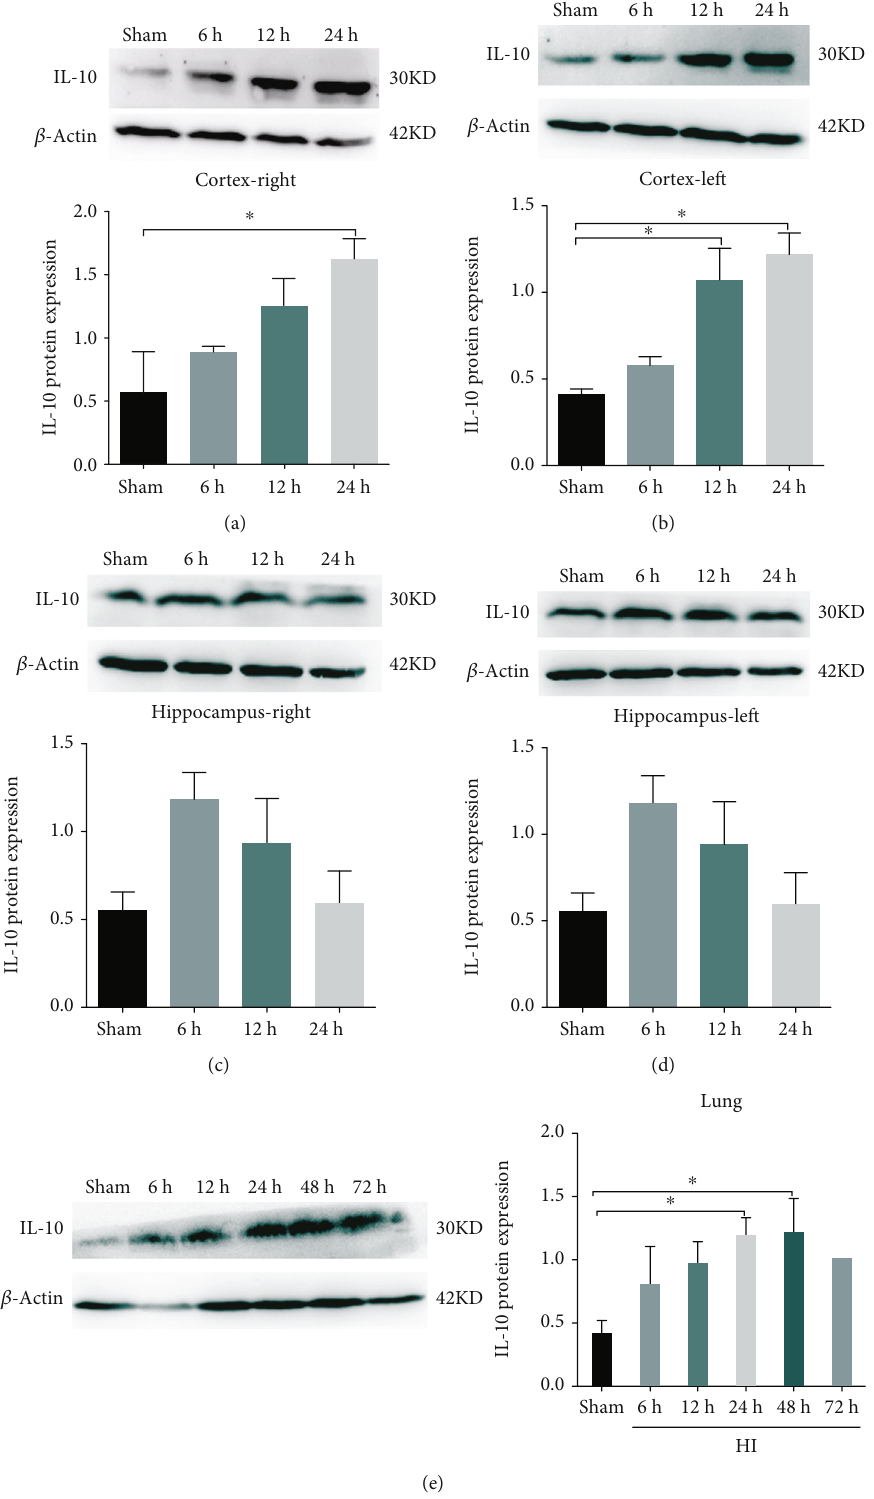
Figure 2: The protein expression of IL-10 in the cortex, hippocampus, and lung tissues after HI. (a) – (d) The western blot stripes and protein expression of IL-10 in the right and left cortex and hippocampus tissues among sham group and HI groups at 6h, 12h, and 24h, respectively. (e) The western blot stripes and IL-10 protein expression in the lung tissues at 6h, 12h, 24 h, 48 h, and 72 h after HI. HI: hypoxia-ischemia; IL- 10: interleukin 10; h: hour. Data are presented as means ± SD , n = 6 /group, ∗ P < 0 : 05